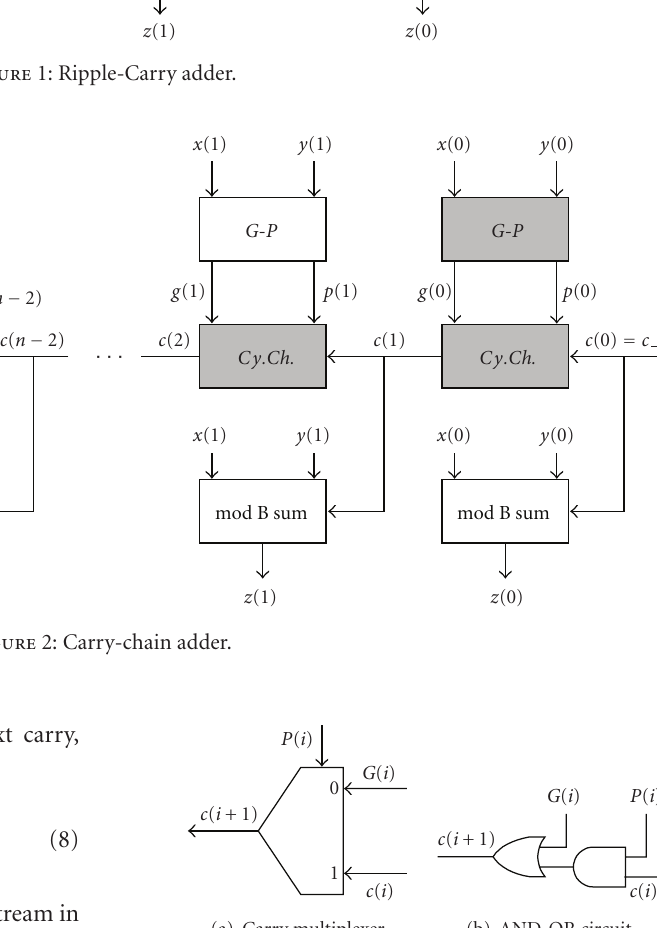
Figure 1: Ripple-Carry adder.